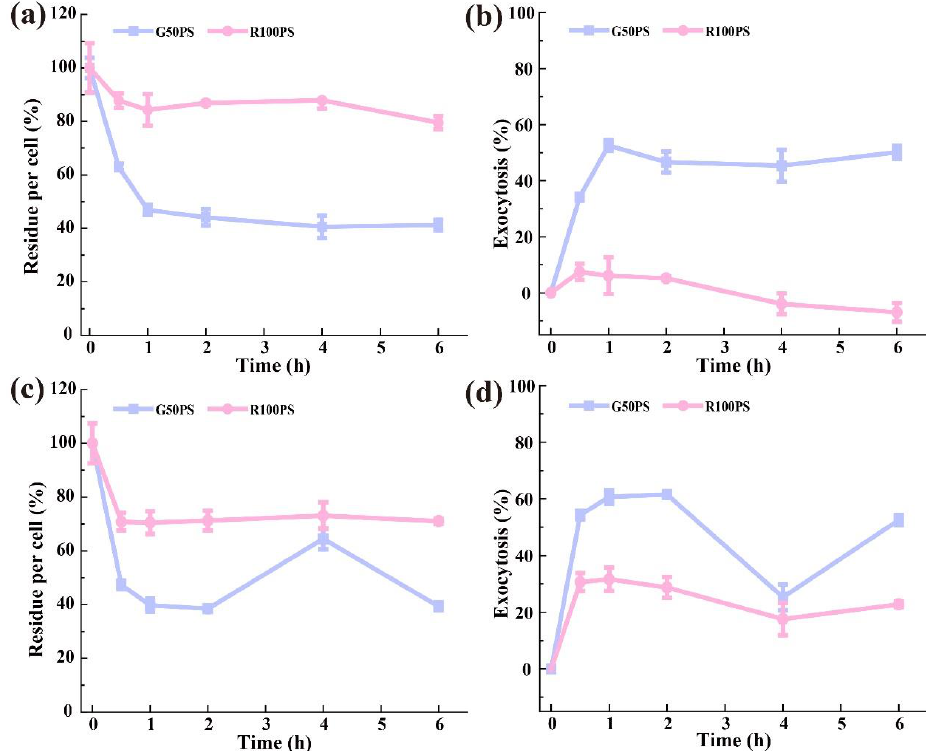
Figure 7. Exocytosis of PS NPs from cells after incubation with 20 μg/mL G50PS and R100PS for 4 h (n = 3). ( a and c ) Remaining contents of PS NPs in A549 cells (a) and BEAS-2B cells (c) , as represented with the mean FI (% of control). ( b and d ) Exocytosis of PS NPs in A549 cells (b) and BEAS-2B cells (d)